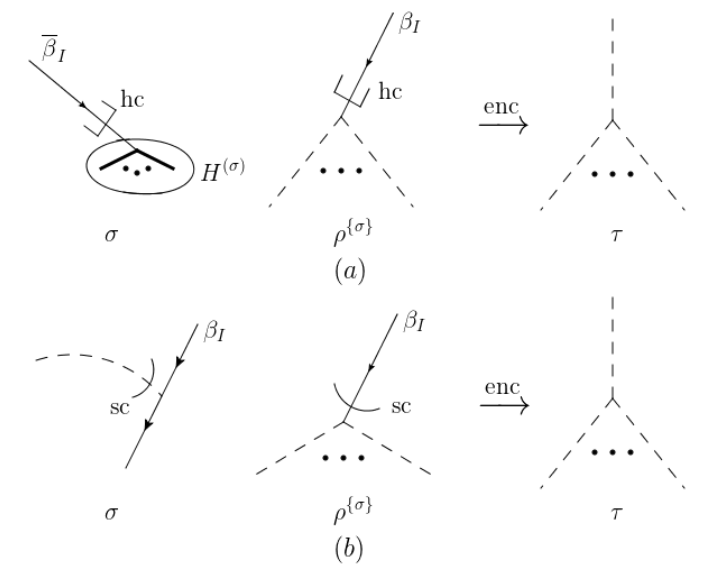
Figure 24. The two generic soft-exotic con(cid:12)gurations. The upper row is from the hard-collinear approximation, while the lower is from the soft-collinear. The con(cid:12)gurations corresponding to (cid:2) (cid:3) (cid:28) (cid:17) enc (cid:27); (cid:26) f (cid:27) g are all-soft, as are drawn at the rightmost. The intermediate dots indicates that there can be one or two lines, but at each vertex the total number of lines attached does not exceed